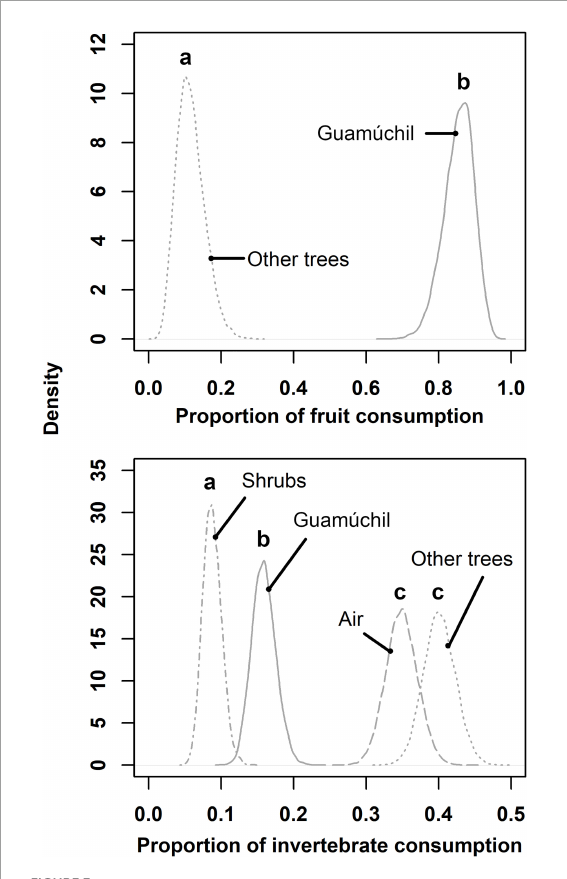
FIGURE3 Estimated proportions of fruits and invertebrates consumed by birds for distinct kinds of feeding sources in Zacualpan, Colima, Mexico. Letters above curves depict statistical differences among estimations.